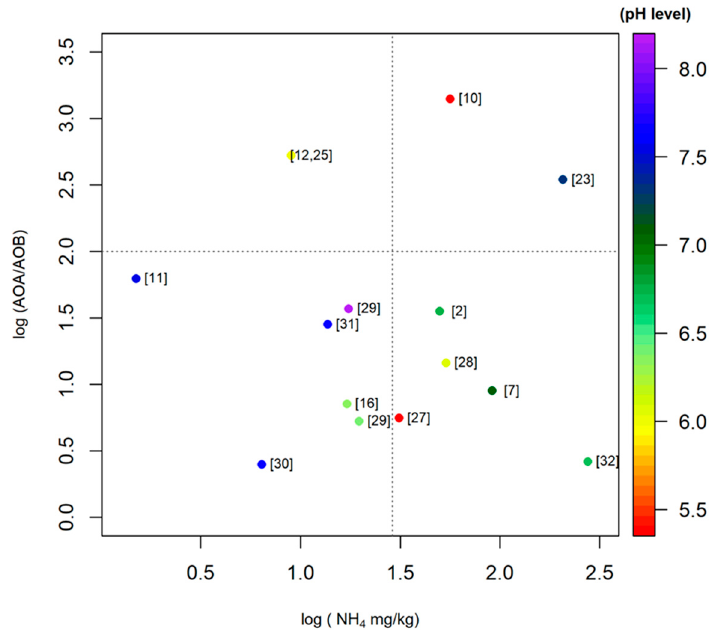
Figure 3. Scatter plot of mean AOA/AOB ratio in different paddy soils (Table 1). The color gradient represents the mean pH level (acidic to alkaline) in selected paddy soils. The numbers of each point correspond to the data sources, i.e., the references. The Logarithmic scale was used because of the large range of values.